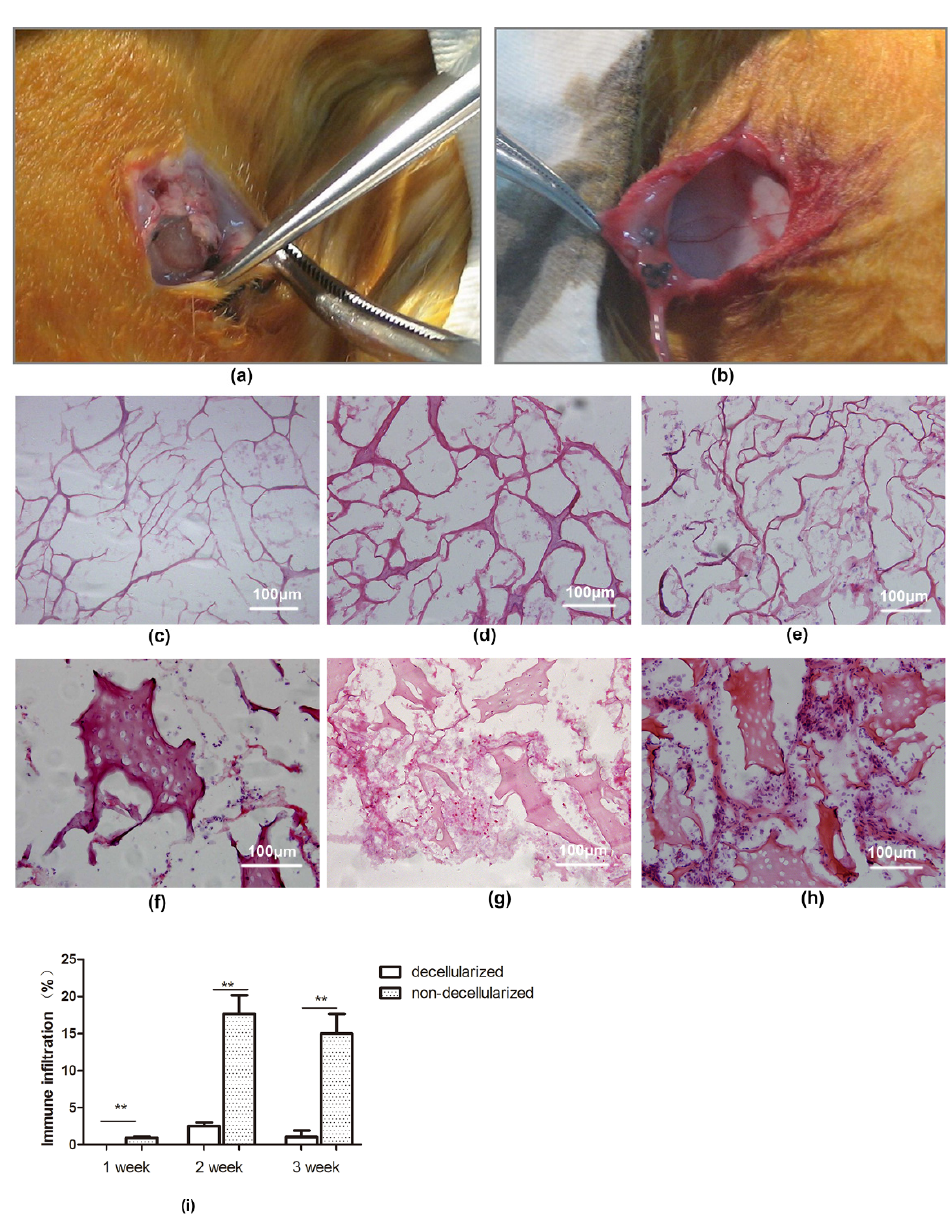
Figure 7. ( a , b ) Immune response assessment of the cartilage transplantation at the incision site after operation in rabbit. Porcine decellularized and non-decellularized cartilage scaffolds at 1 week after surgery ( c , f ); 2 weeks after surgery ( d , g ); and 4 weeks after surgery ( e , h ) (HE, original magnification × 200). ( i ) Quantitative results of the infiltrated cells in decellularized and non-decellularized cartilage scaffolds. ** p < 0.01.